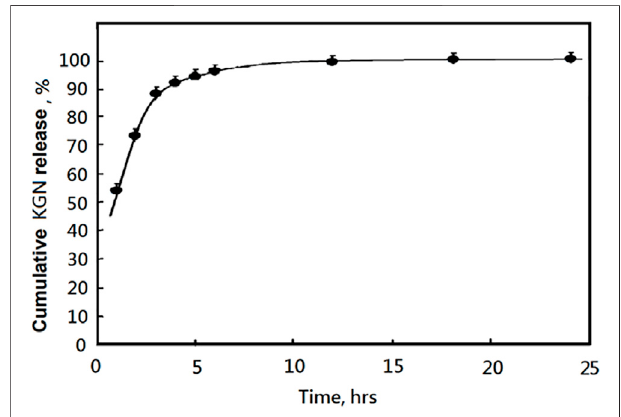
FIGURE 4 | The released KGN percentages of KGN-loaded mPEG-Hz- b -PCL nananomicelles determined by HPLC under pH 7.4 at 37 °